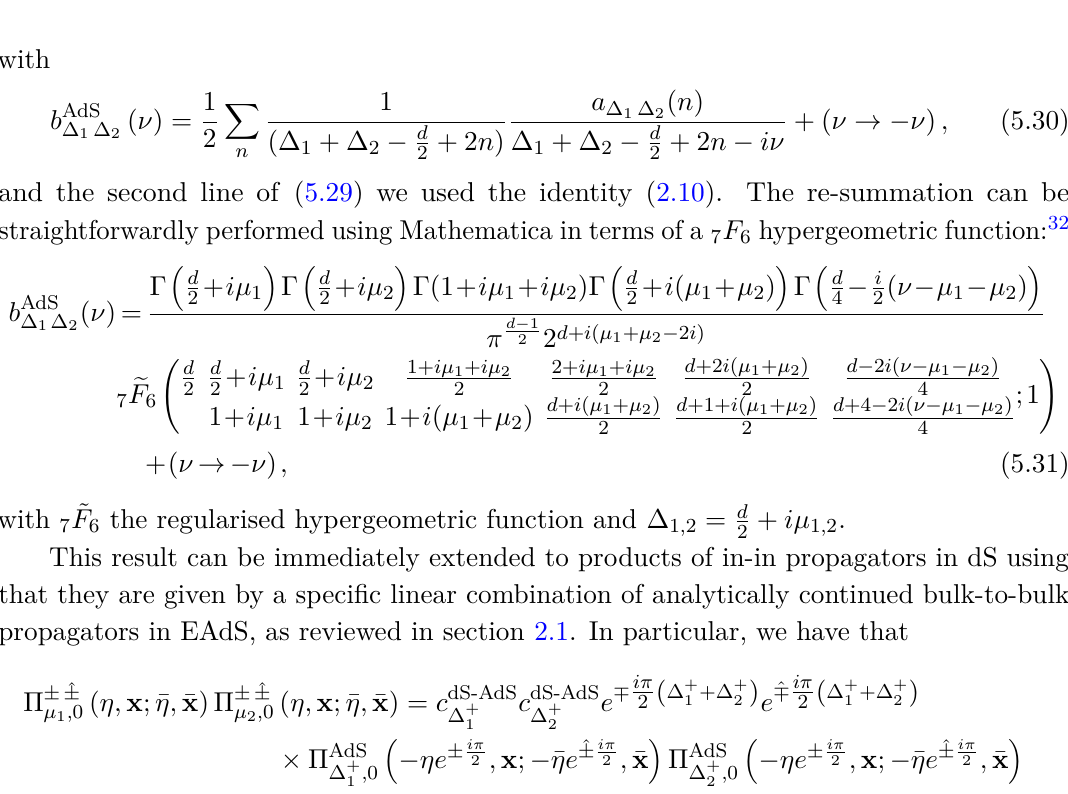
. ν,J ( ν ) in dS ∆ 1 ... ∆ n ( ν ) , This relation is given in ∆ 1 ... ∆ n